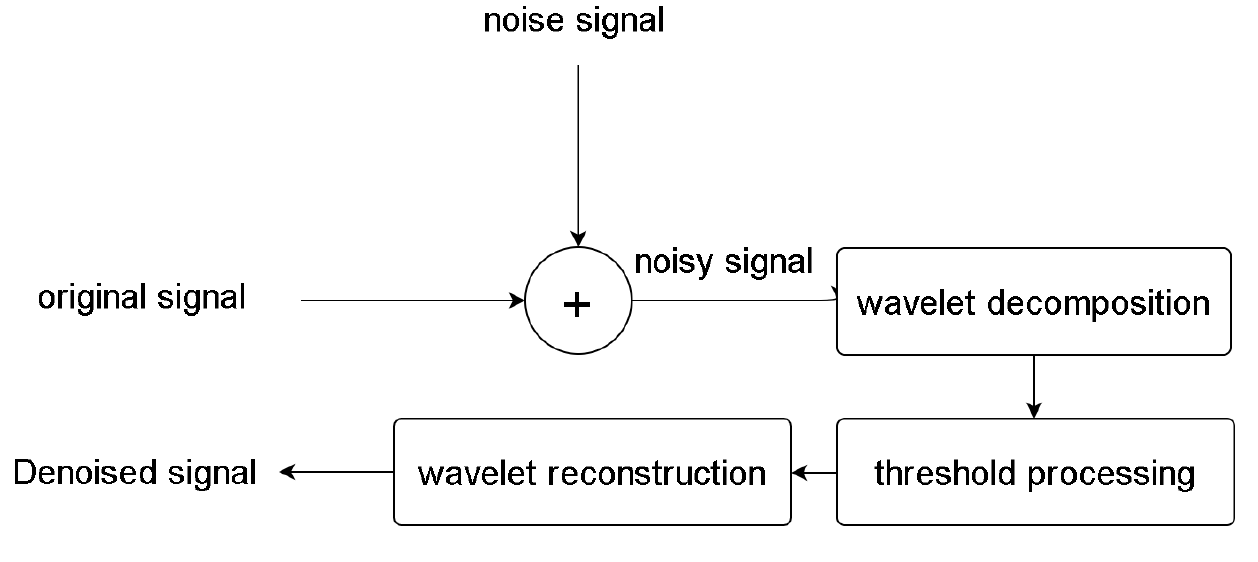
Figure 2. Wavelet denoising